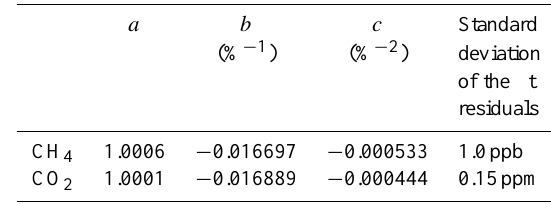
Table 2. a , b and c are the coefficients of the quadratic fit to [ X ] Wet / [ X ] Dry versus [H 2 O]. These values can then be used to de- termine dry-air mole fractions using Eq.